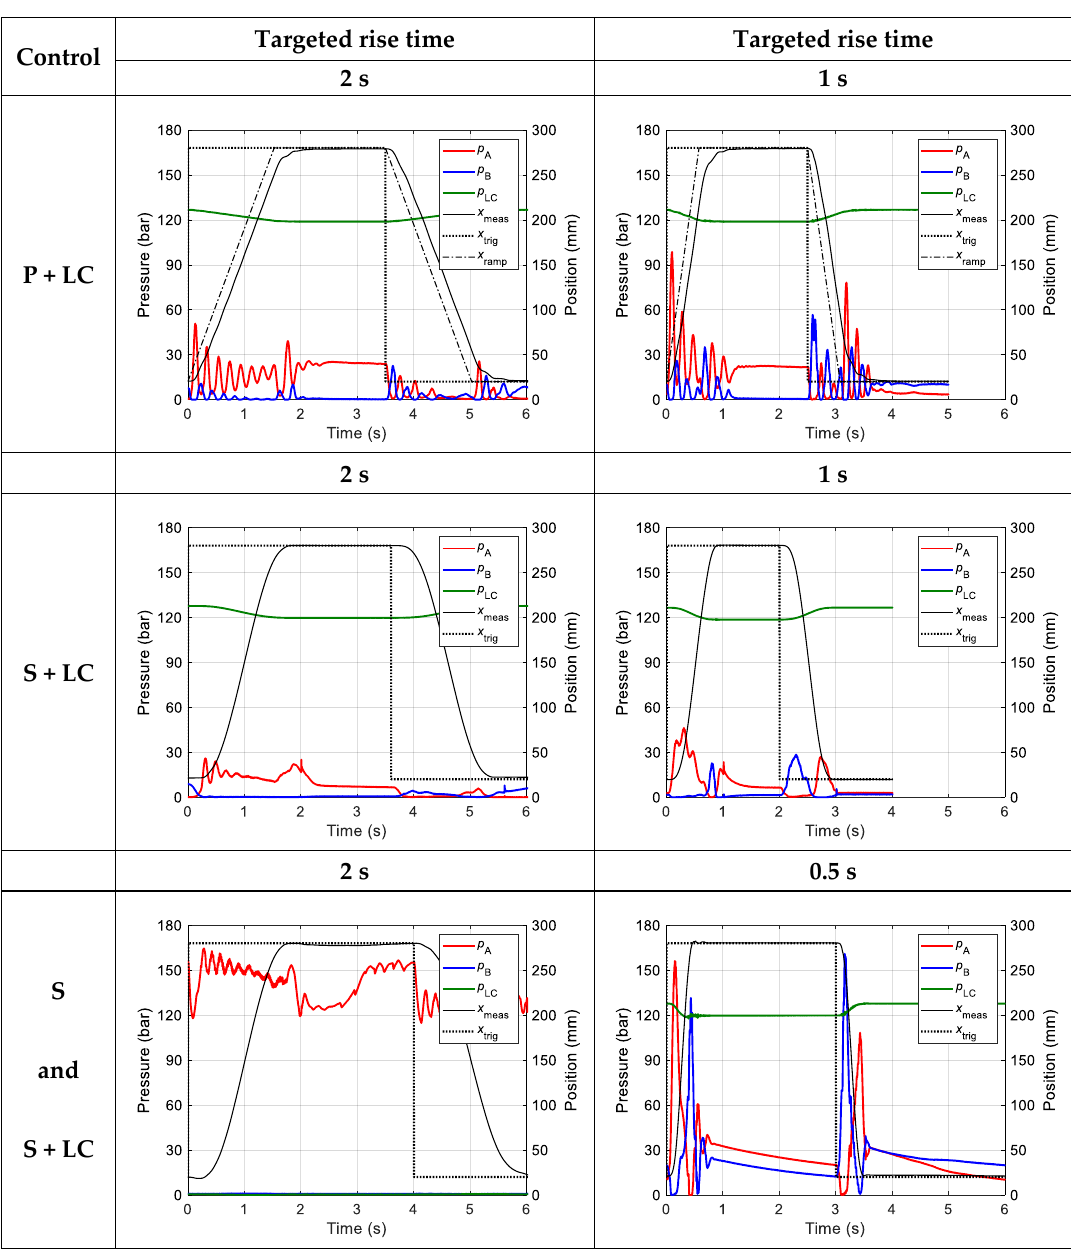
Figure 6. Pressure in actuator chambers A and B, as well as pressure in load compensation (LC) circuit during one lift-lower cycle with different controllers and load compensation arrangements.